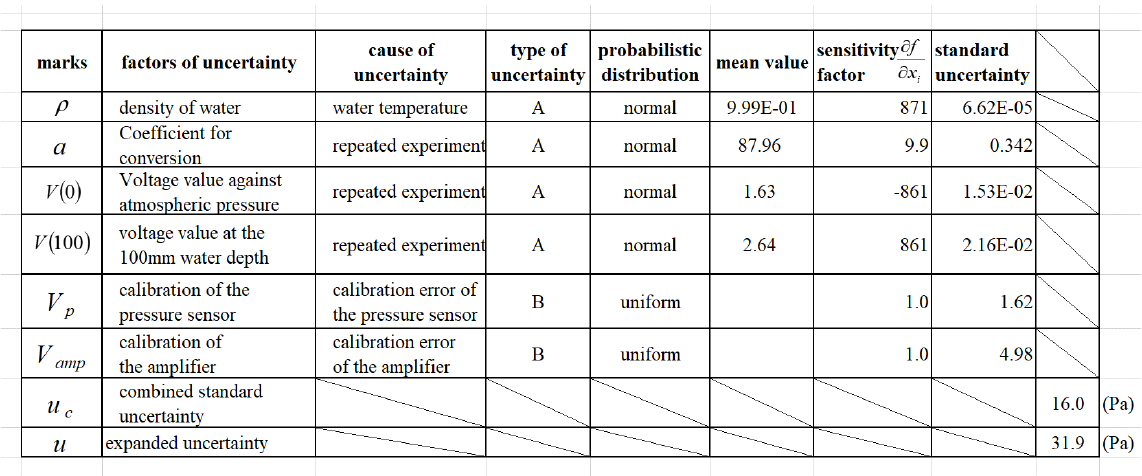
Table 1. Budget table for estimation of uncertainty concerning the pressure value at 40mm position from the